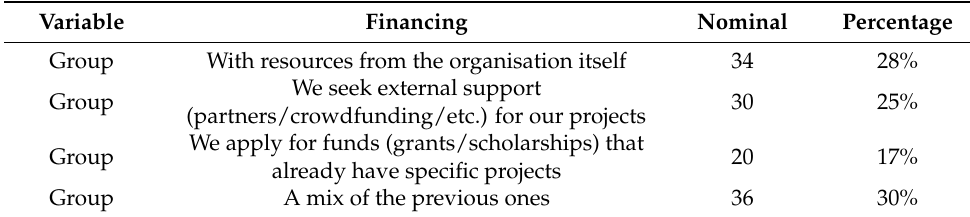
Table 24. Financing Collaborative